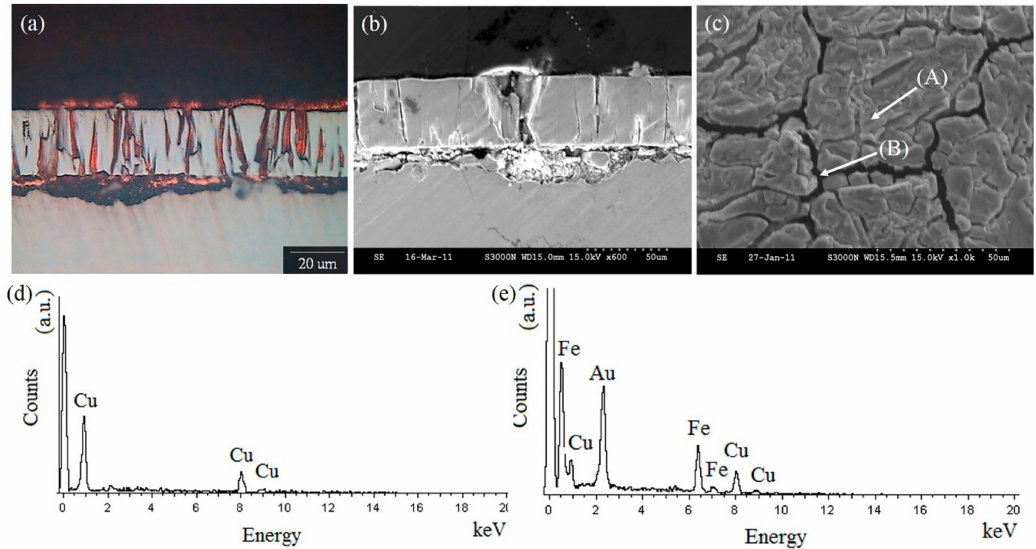
Figure 13. Cross-sectional micrograph of the pre-etched heat-hardened Cr–C / Cu-coated sample observed by ( a ) optical microscope (OM) and ( b ) SEM after immersion tests in 200 g / L CuSO 4 · 5H 2 O + 70 g / L H 2 SO 4 solution; ( c ) Surface morphology of the pre-etched heat-hardened Cr–C sample after immersion tests in 200 g / L CuSO 4 · 5H 2 O + 70 g / L H 2 SO 4 solution ( d ) EDS-analysis on position A; ( e ) EDS analysis on position